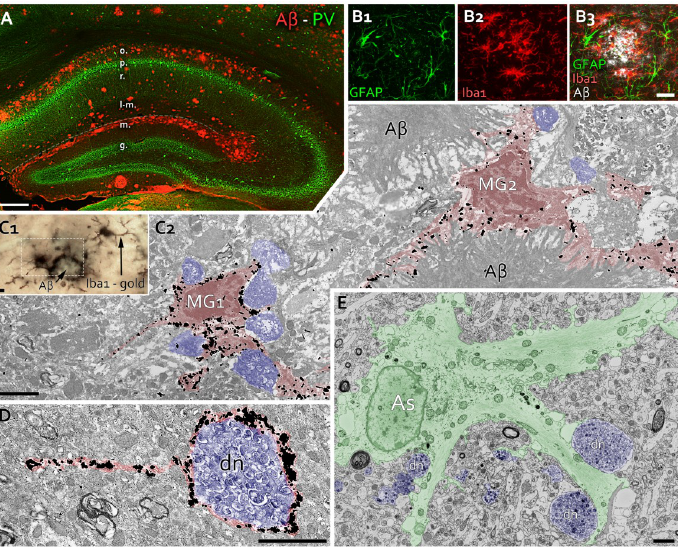
Fig 1. Rings of microglia and astroglia surround plaques and dystrophic neurites in APP NL-F mice. A: Fluorescent image shows a hippocampal section of a 21-month-old APP NL-F mouse. A β depositions (red) are abundant in strati oriens, lacunosum-moleculare and moleculare. PV-positive INs (green) seem unaffected. (o.: str. oriens, p.: str. pyramidale, r.: str. radiatum, l-m.: str. lacunosum-moleculare, m.: str. moleculare of dentate gyrus, g.: str. granulosum of dentate gyrus). Scale bar: 250 μ m. B : Fluorescent images show GFAP-positive astrocytes (B1, green) and Iba1-positive microglia (B2, red) around an A β plaque (B3, white) in str. lacunosum-moleculare of a 20-month-old APP NL-F mouse. Scale bar: 20 μ m. C: Correlated light (C1) and electron microscopic images (C2 is from area with dashed line in C1) show Iba1 immunogold labeled microglia cells (MG1, MG2, red), which cover A β depositions and adjacent dystrophic neurites (blue). Scale bars: 2 μ m. D: An Iba1 immunogold labeled microglial process (red) covers an autophagic vesicle-containing dystrophic neurite (dn, blue), separating it from the adjacent neuropil. Scale bar: 2 μ m. E: Astroglial processes in an APP NL-F mouse (As, green) separate dystrophic neurites (dn, blue) filled with electrondense autophagic materials, from the healthy-looking tissue. Scale bar: 2 μ m.